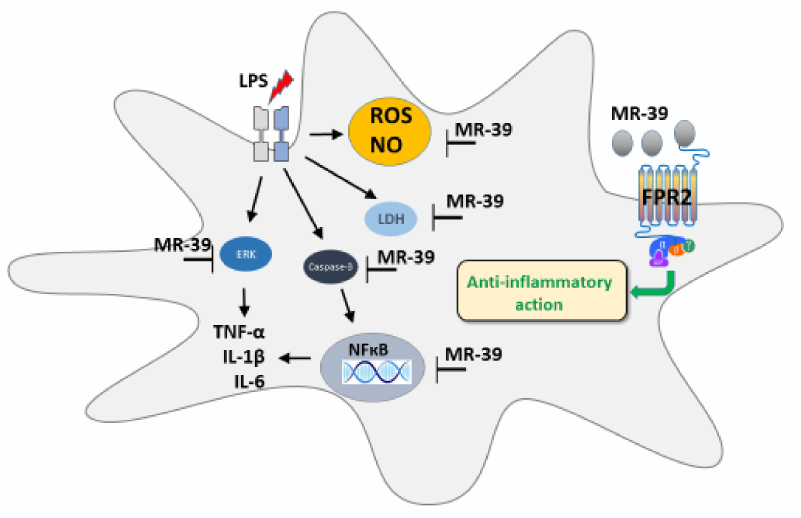
Figure 12. Schematic illustration of the targets of beneficial MR-39 action in LPS-stimulated microglial cells. The varied action of MR-39 in microglia cells includes reduction of the lactate dehydrogenase re- lease, inhibition of the caspase-3 activity, and reactive oxide production as well as nitric oxide release evoked by bacterial endotoxin treatment. Moreover, MR-39 exerts an anti-inflammatory effect related to the inhibition of the synthesis of pro-inflammatory cytokines (IL-1 β , TNF- α , IL-6). This action is mediated by the reduction of ERK1/2 and the NF- κ B transcription factor phosphorylation.